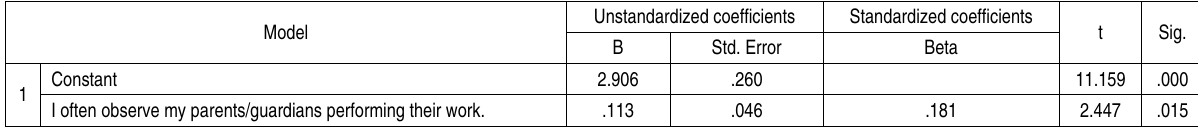
Table 7. Regression between parents’ work and entrepreneurial